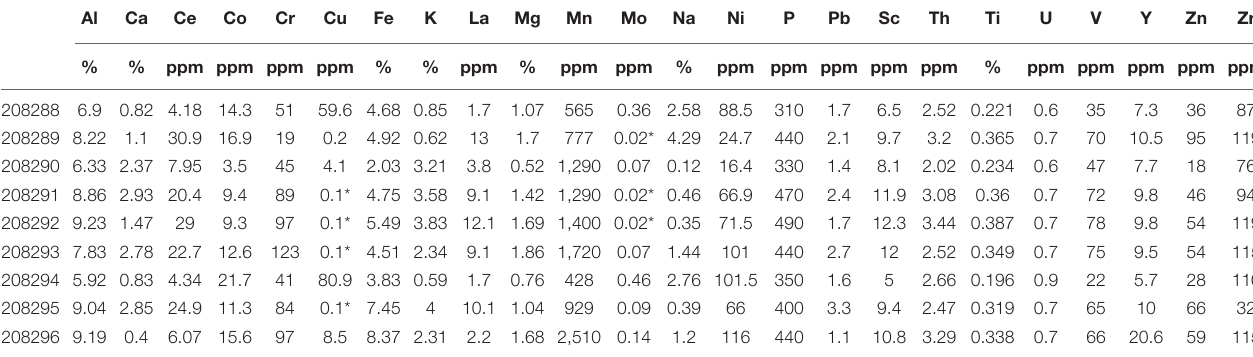
TABLE 1 | Major and minor element abundances.